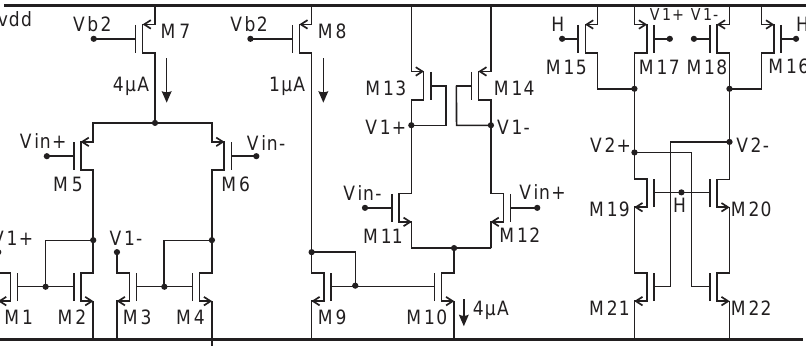
Figure 13. Rail-to-rail input clocked comparator used in the single-slope ADC. The rail-to-rail input structure is used for this comparator because the input voltage (Vi) varies